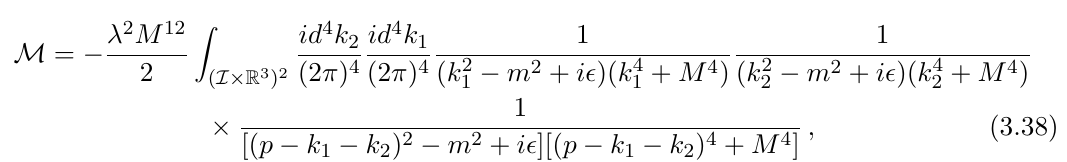
Figure 3 . Left panel: real part of the amplitude with m = M = 1 . The real physical threshold is at p = 2 and the virtual threshold at p 0 √ 2 and M = 1 . For such values of the masses, the two cusps m = 1 /